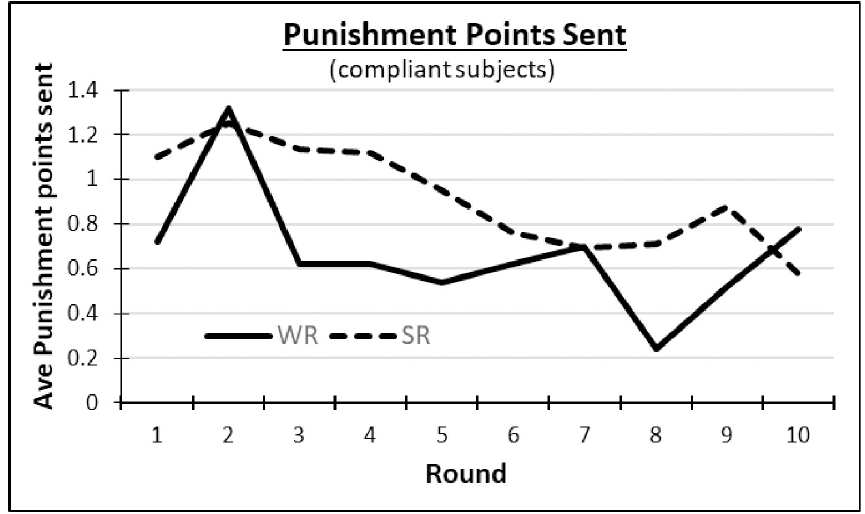
Fig 3. Average punishment points